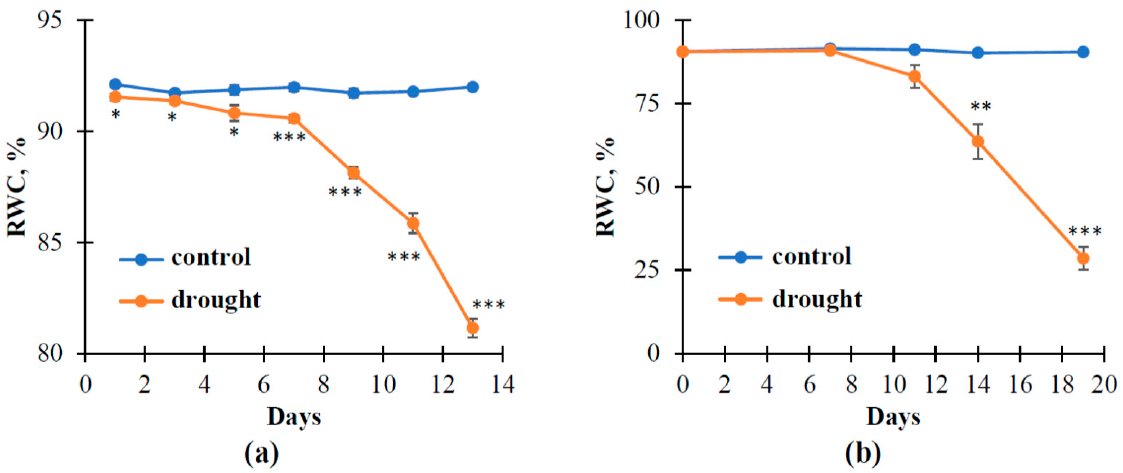
Figure 2. The influence of soil drought on relative water content (RWC) in pea ( a ) and wheat ( b ) under controlled conditions of laboratory. * p < 0.05; ** p < 0.01; *** p < 0.001. After this, we analyzed the changes in RI (613, 605) and RI (670, 432) in pea and wheat caused by soil drought. These indices were measured at the view from above (90 ◦ ) and side view (45 ◦ ). It was shown that RI (613, 605) and RI (670, 432) were the most effective indices for revealing soil drought’s action on pea and wheat plants among 46 other reflectance indices (Table 1), which were shown in [38]. Figure 3 shows the dynamics of changes in RI (613,